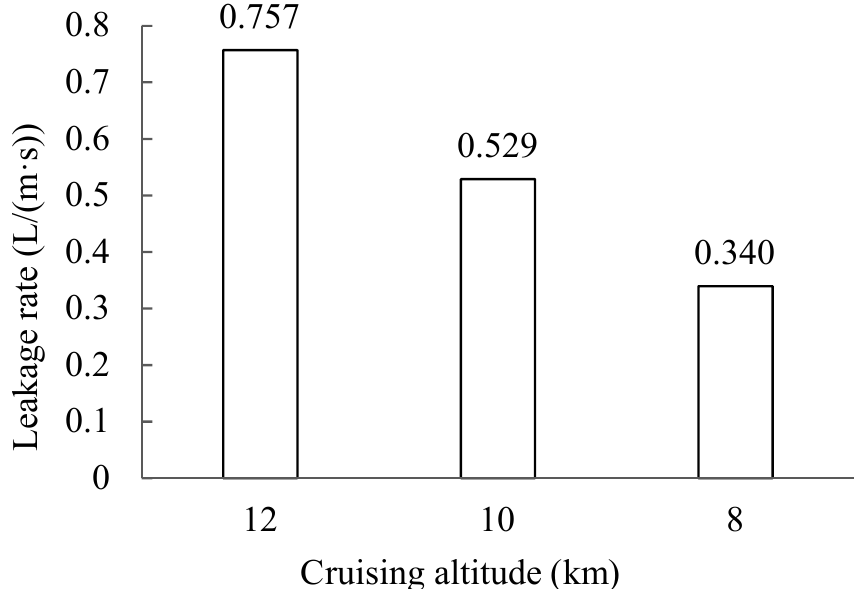
Figure 7. Comparison of leakage rate at different cruising altitudes.